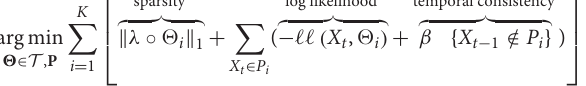
FIGURE 1 | The framework of the feature exaction and the